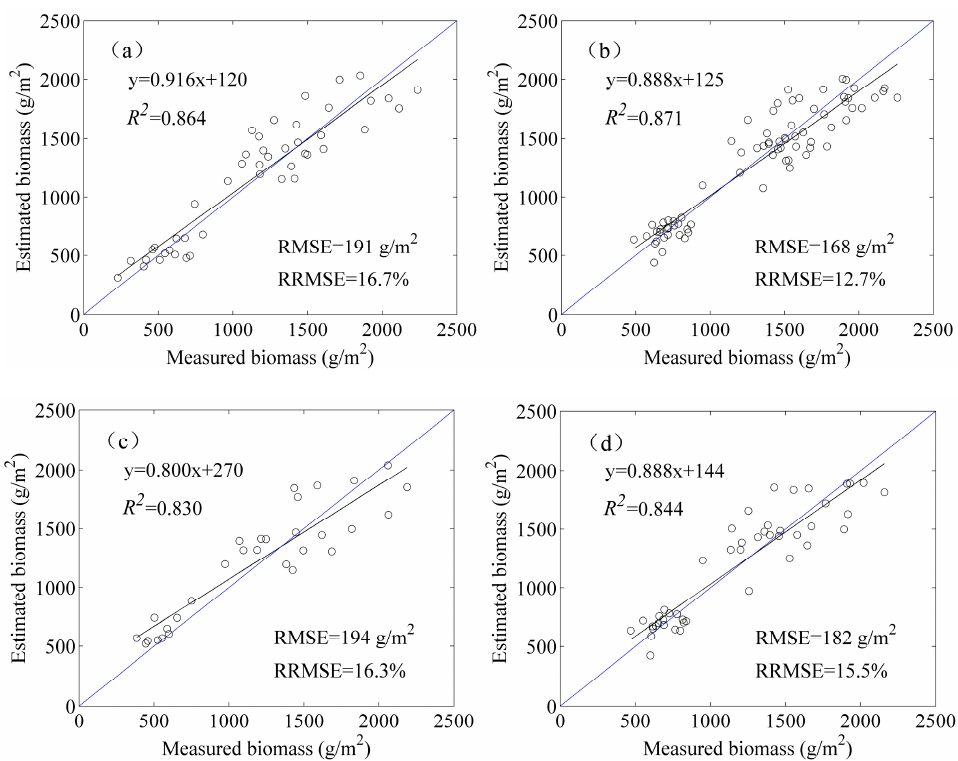
Figure 9. Comparisons between the measured and estimated winter wheat biomass: ( a ) With the 100-m data at Site 1; ( b ) With the 100-m data at Site 2; ( c ) With the 300-m data at Site 1; and ( d ) With the 300-m data at Site 2.